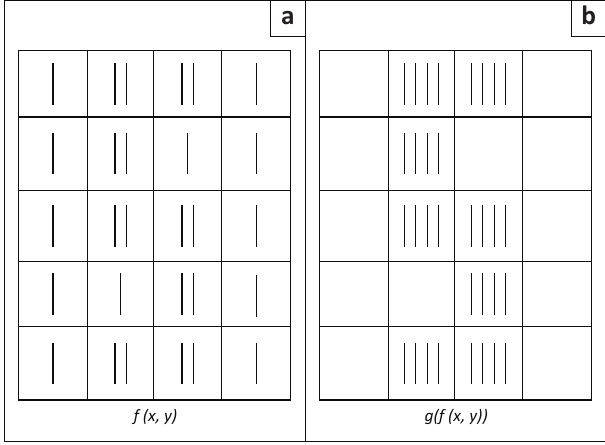
FIGURE 5: (a) Low contrast image. (b) Increased contrast after function